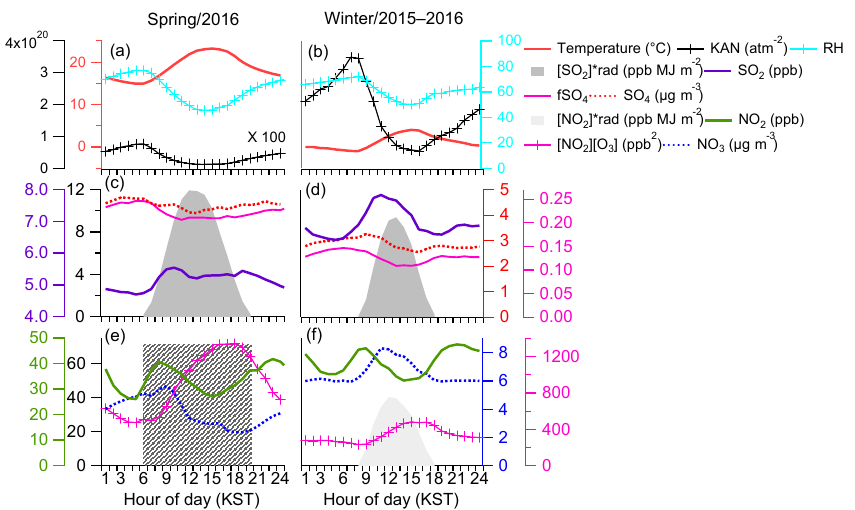
Figure 4. One-hour averaged diurnal profiles for sulfate, nitrate and various parameters and proxies for formation pathways in winter (5 December 2015–21 January 2016) and spring (14 April–15 June 2016); temperature, relative humidity and K AN as the equilibrium constant for gas-to-particle partitioning for ammonium nitrate in (a) 2016 and (b) 2015. The 1h averaged diurnal profiles of SO 2 , SO 2 − f SO 4 and [SO 2 ] times solar radiation as a proxy for daytime H 2 SO 4 formation in (c) spring 2016 and (d) winter 2015; the 1h averaged diurnal profiles of NO 2 , NO 3 , and [NO 2 ][O 3 ] as a proxy for nighttime formation of HNO 3 and subsequently particulate nitrate, and [NO 2 ] times solar radiation as a proxy for daytime HNO 3 formation in (e) spring 2016 and (f) winter